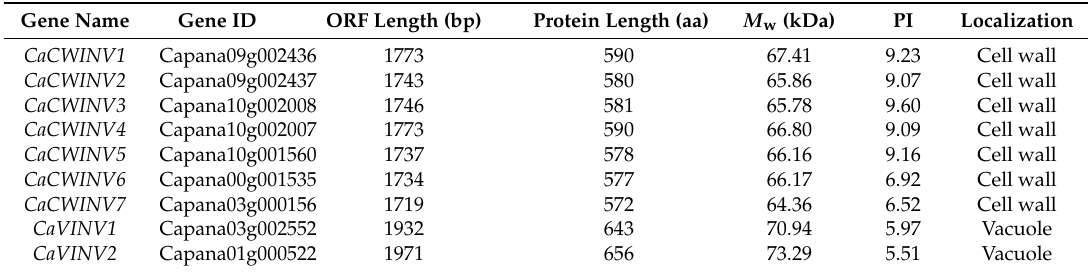
Table 1. Basic information of seven pepper alkaline/neutral invertase genes ( CaAINVs ).